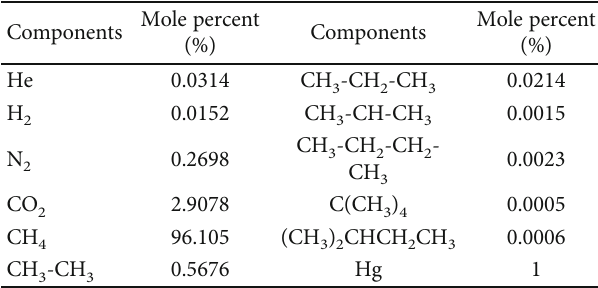
Table 1: Components of natural